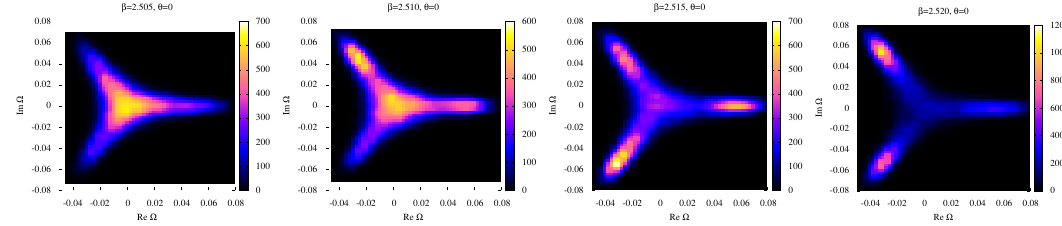
Figure 2 . Two dimensional histogram on the Re Ω - Im Ω plane. The results at β = 2 . 505 , 2.510, 2.515 and 2.520 are shown from left to